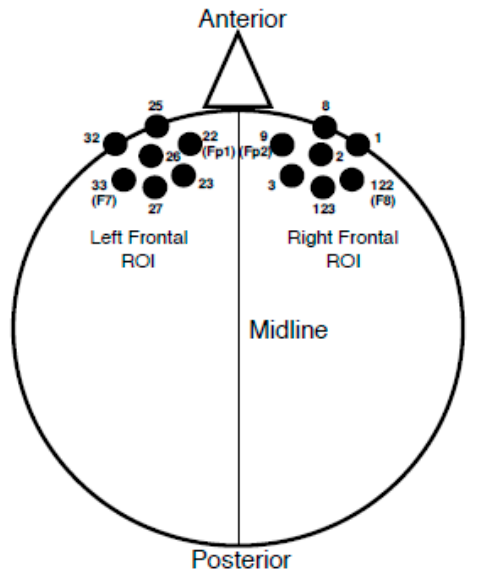
Figure 2. Frontal ROI Electrode Locations. Left frontal ROI electrode locations consist of